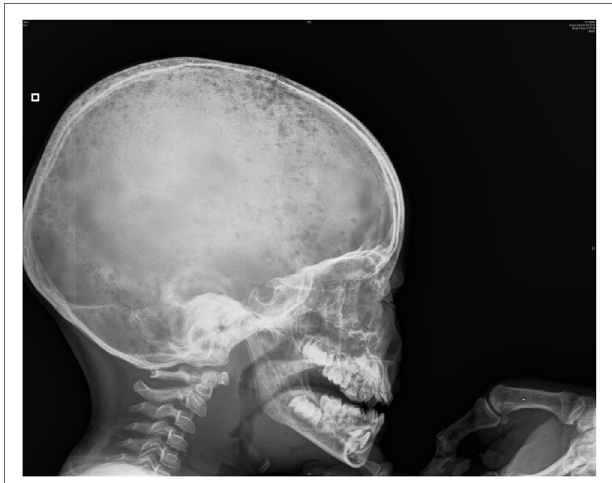
FIgURe 1 | Skull radiograph—multiple lytic